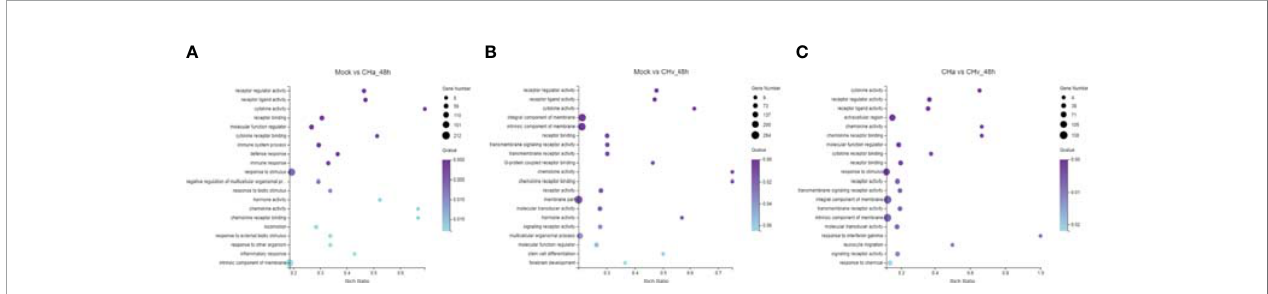
FIGURE 2 | Top 20 Gene ontology (GO) terms of DEGs expressed in DPV CHv or CHa infected MM cells. The top 20 GO terms were selected according to p -value < 0.05. (A) Mock and CHa. (B) Mock and CHv. (C) CHa and CHv.